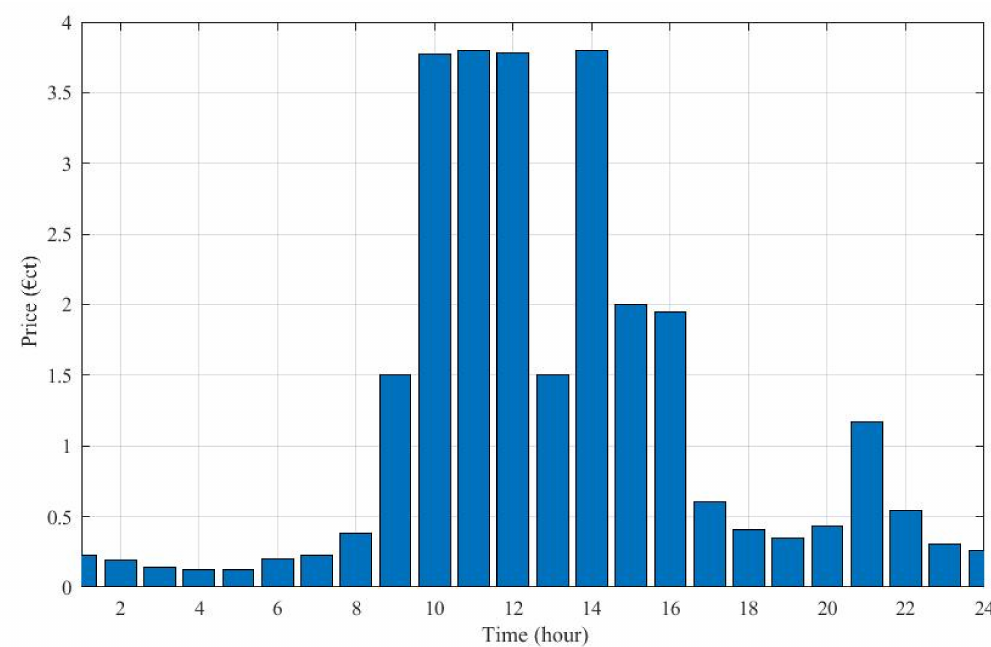
Figure 8. Real utility market